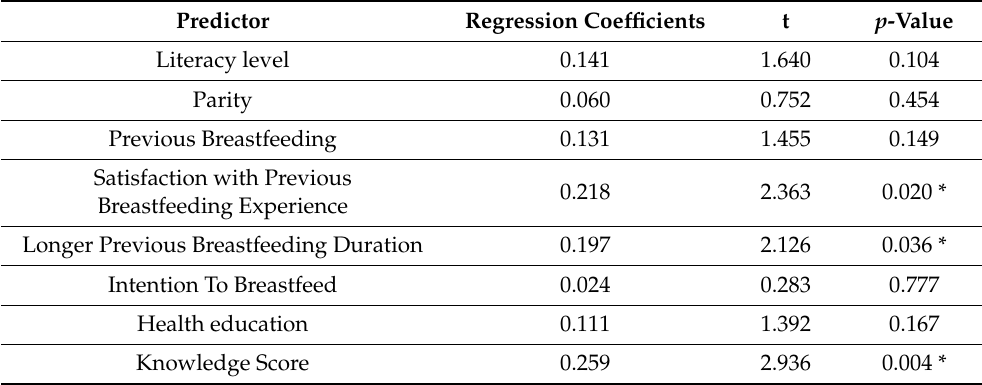
Table 4. Predictors of breastfeeding self-efficacy among expectant mothers with gestational diabetes mellitus (GDM) ( n =